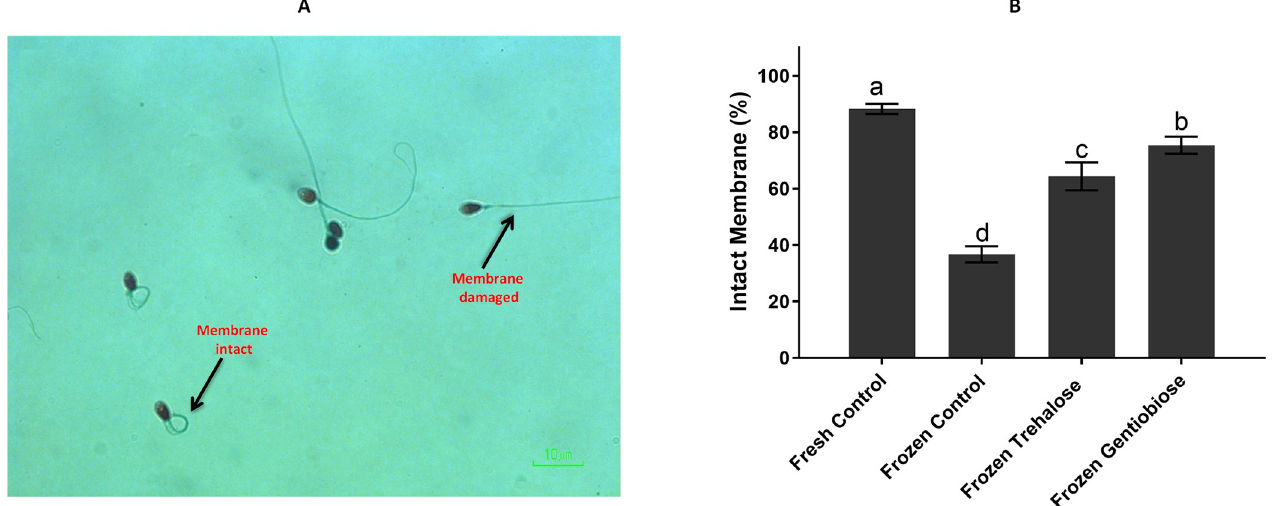
Fig 4. Membrane integrity of sperm was estimated using the HOS test. The membrane intact and damaged are observed (A), and the percentage of membrane-intact differs among the experimental groups (B). The assigned letters a, b, c, and d indicate significant differences (P < 0.05). Values are expressed as mean ± SD, Tukey test; n =